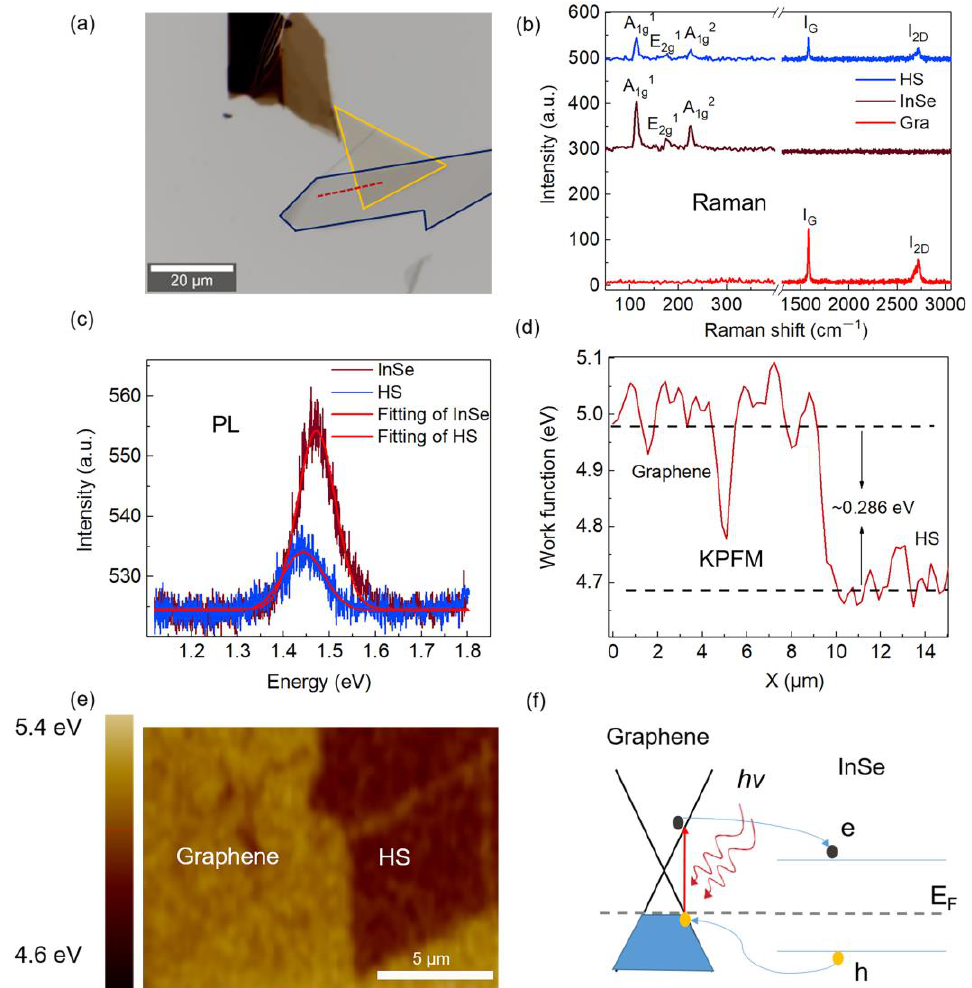
Figure 2. ( a ) Optical image (the blue line is bottom graphene and the yellow line is top InSe), ( b ) Raman spectrum, ( c ) PL spectrum of graphene, InSe and G/InSe HS. ( d ) Work function difference of graphene and HS (corresponding to the red dashed line region in Figure 2a). ( e ) KPFM surface work function image of graphene and HS. ( f ) The band alignment of the heterostructure.